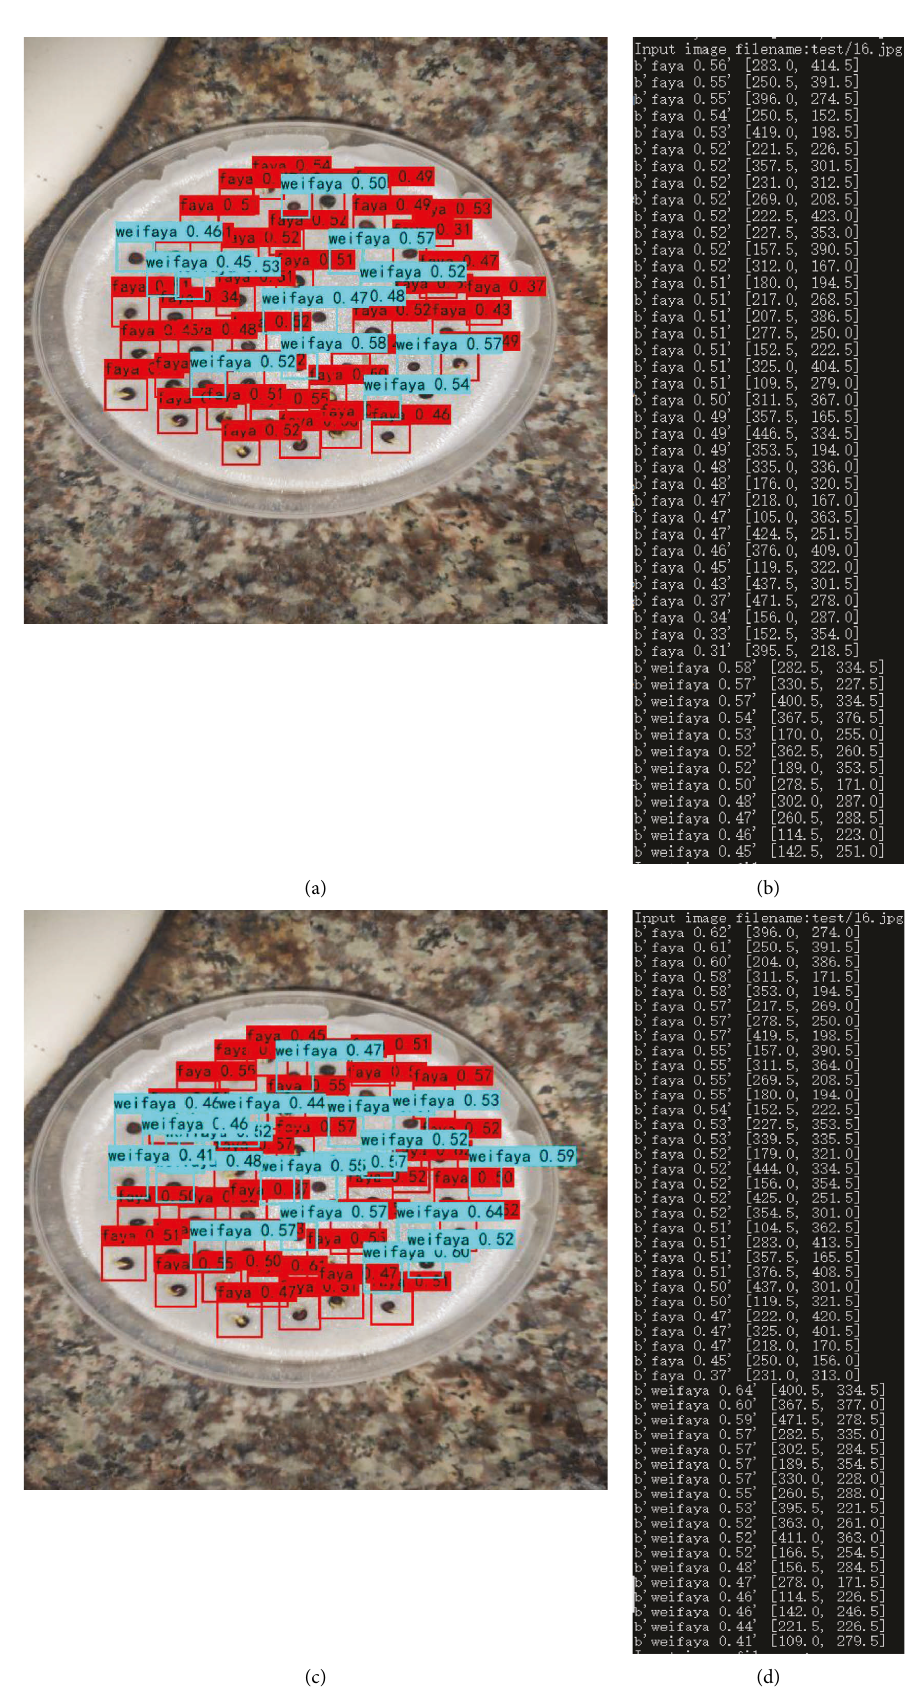
Figure 11: Test results for dense small targets in complex backgrounds. (a) The target identified by the original model. (b) The score and center position of the original model. (c) The target identified by the new model. (d) The score and center position of the new